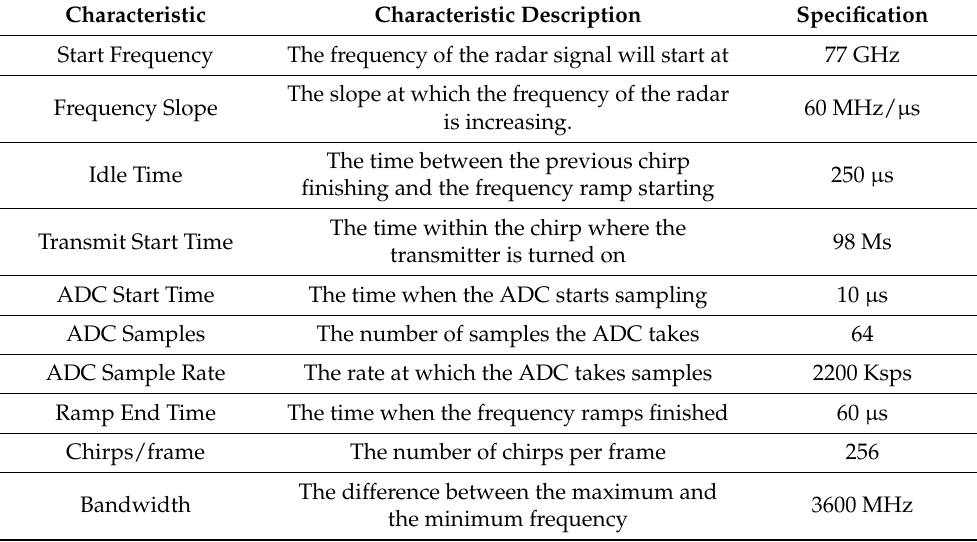
Table 1. Radar parameters, definition and values used for radar configuration to be used for the tests.